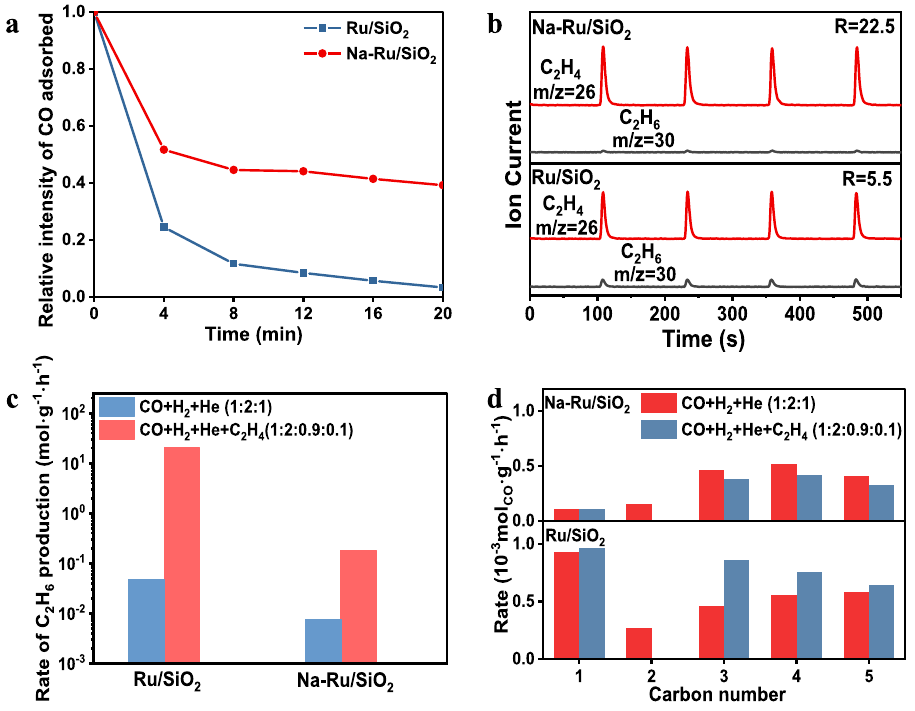
Fig.3|ExplorationofthereactivityofchemisorbedH 2 overRu/SiO 2 andNa-Ru/ SiO 2 . a Relative intensity of linear-adsorbed CO remained during stepwise hydro- genationat533K determinedbyin situDRIFTS.The ordinates arethe evolution of integrated peak area of CO ad species under H 2 fl ow divided by that before H 2 addition at 533K. b Transient response curves obtained during pulses of 370 μ L